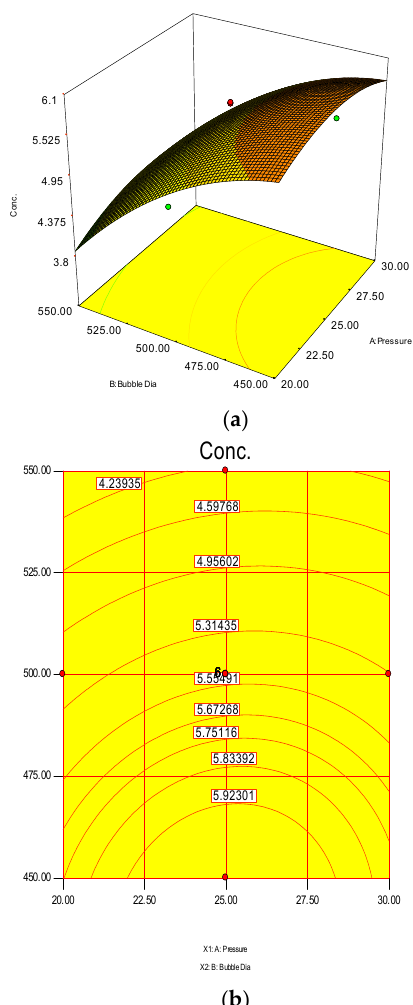
Figure 5. 3D response surface ( a ) with 2D contour plot ( b ) of bubble diameter and pressure on polymerisation.